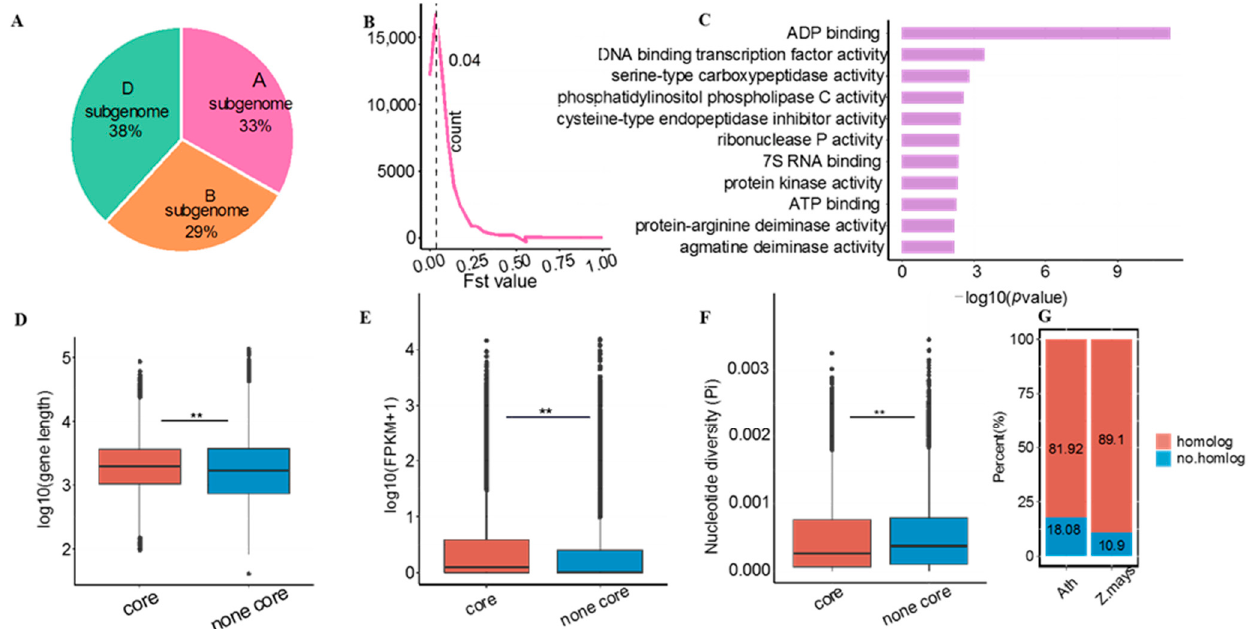
Figure 1. Identification of core genes in wheat. ( A ), The percentage of core genes distributed in subgenomes, 33% for A_subgenome, 29% for B_subgenome and 38% for D_subgenome. ( B ), Population differentiation index of core genes between cultivars and landraces, dashed line represents Fst = 0.04. ( C ), GO enrichment analyses of core genes with a population differentiation index greater than 0.25. ( D - F ) , Comparisons of core and non-core gene lengths ( D ), expression levels ( E ), and nucleotide diversity ( F ). ( G ), Proportion of core genes with homolog genes in maize and Arabidopsis . Where * indicates that p < 0.05, ** means p < 0.01.